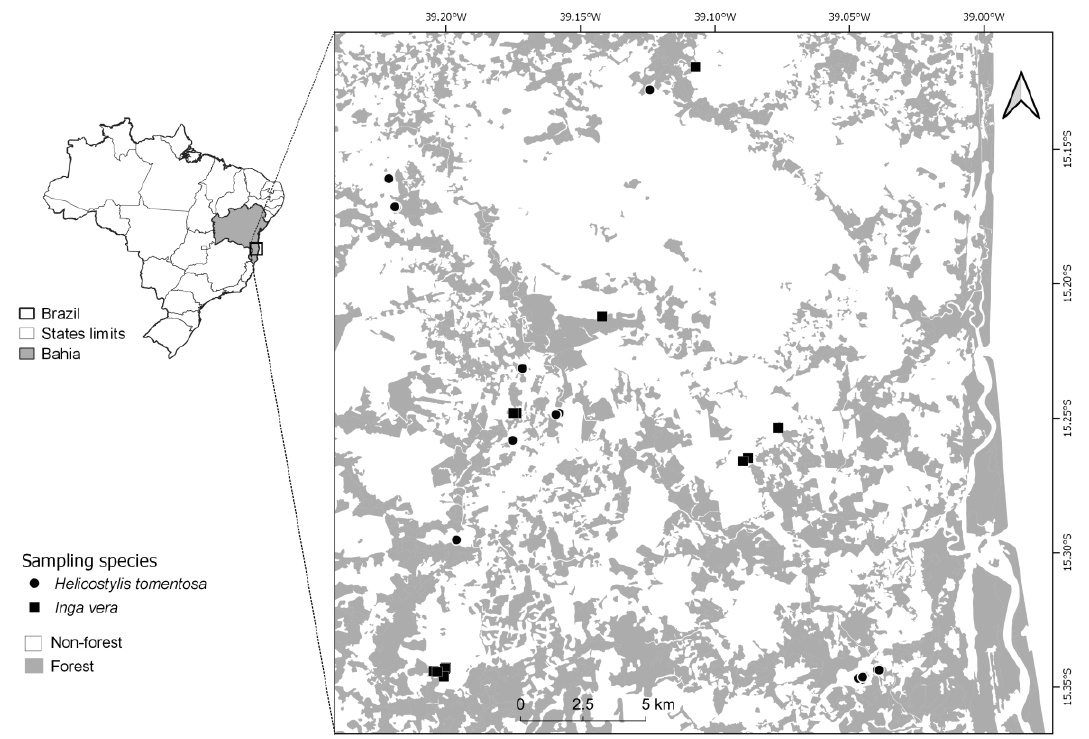
Figure 1. Map depicting all individuals sampled (19 Helicostylis tomentosa and 15 Inga vera ; some points are overlapping on the map, due to its large scale) which were used for the seed removal rate estimates and for calculating the amount of Brazilian Atlantic forest (Bahia, Brazil).